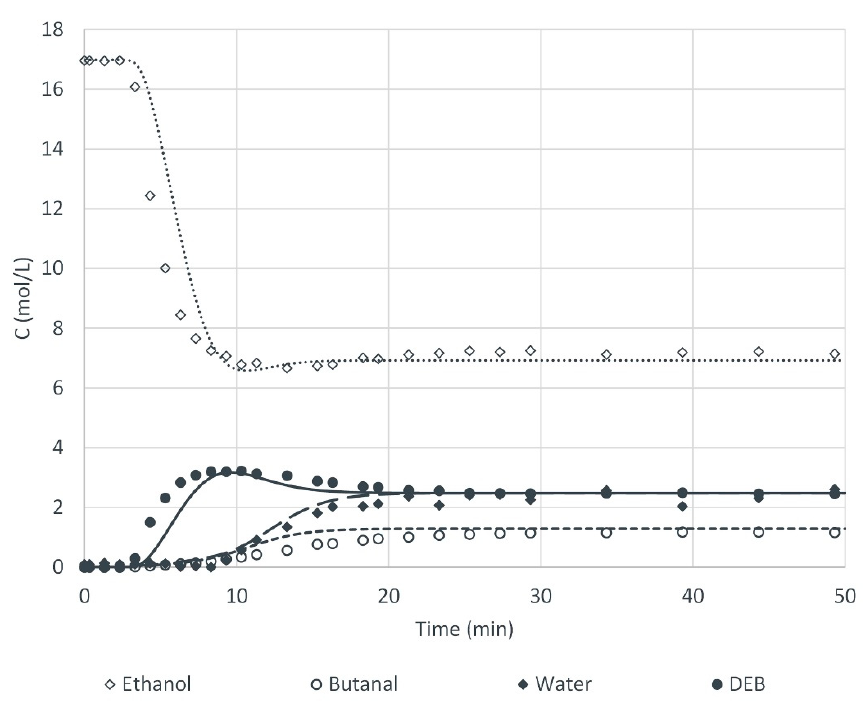
Figure 6. Reaction breakthrough curve experimental conditions provided in Table 2 for experi- ment 3 [22].